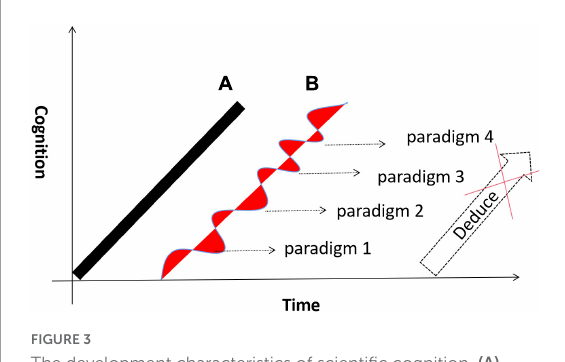
FIGURE3 The development characteristics of scientific cognition.